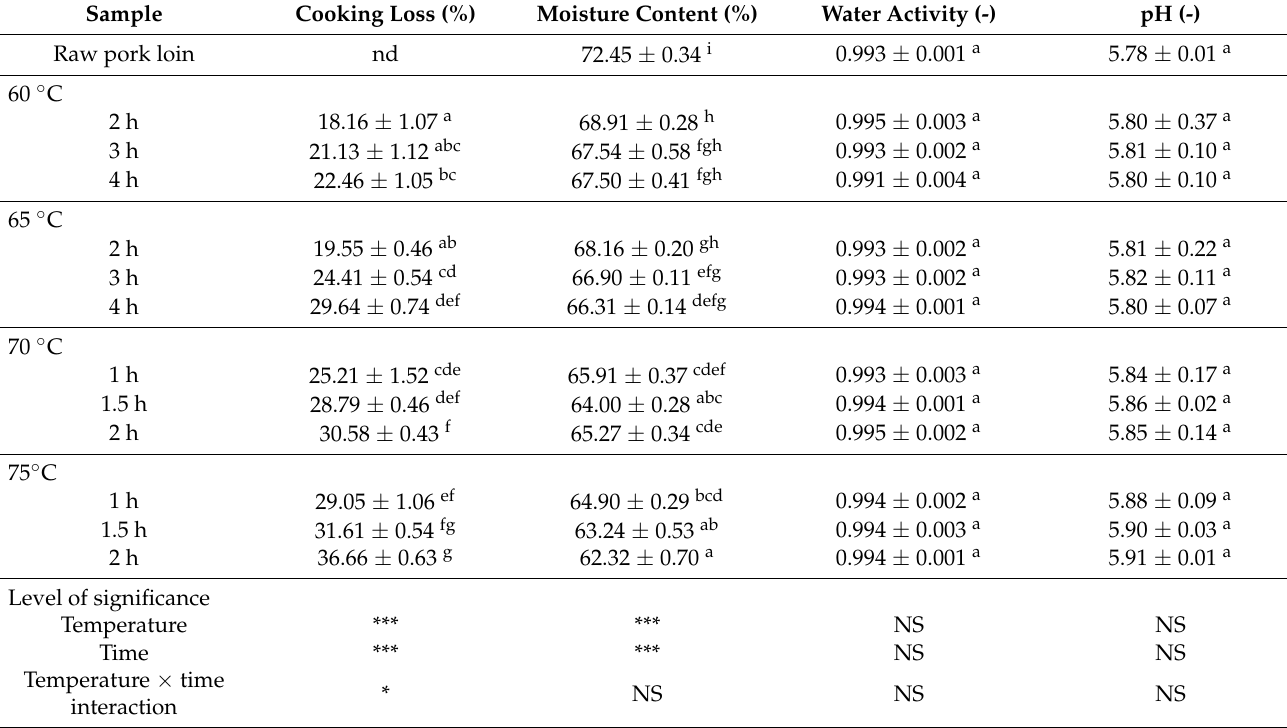
Table 1. Cooking loss, moisture content, water activity and pH value of sous vide cooked pork loin (mean ±